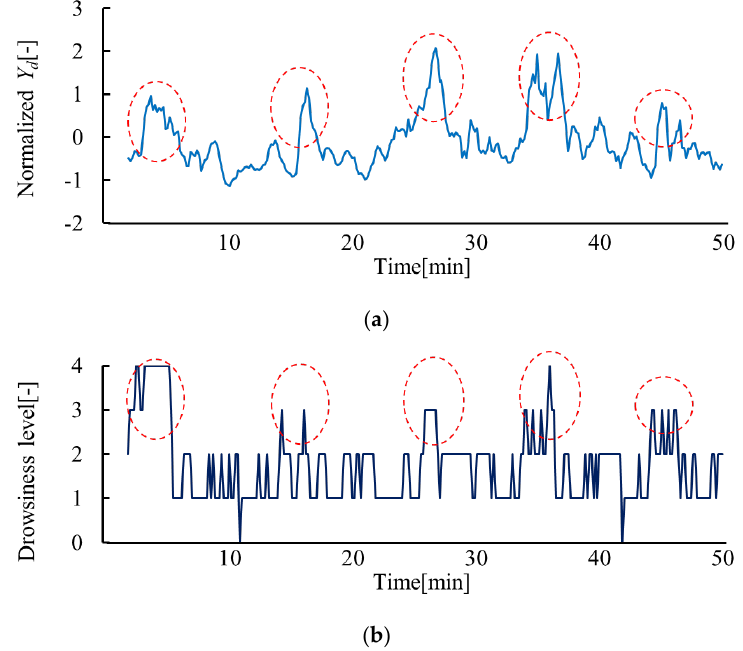
Figure 10. Changes in the normalized Yd ( a ) and drowsiness level ( b ), (subject C). (a) Time series of normalized Yd, ( b ) Time series of the value of the drowsiness level.